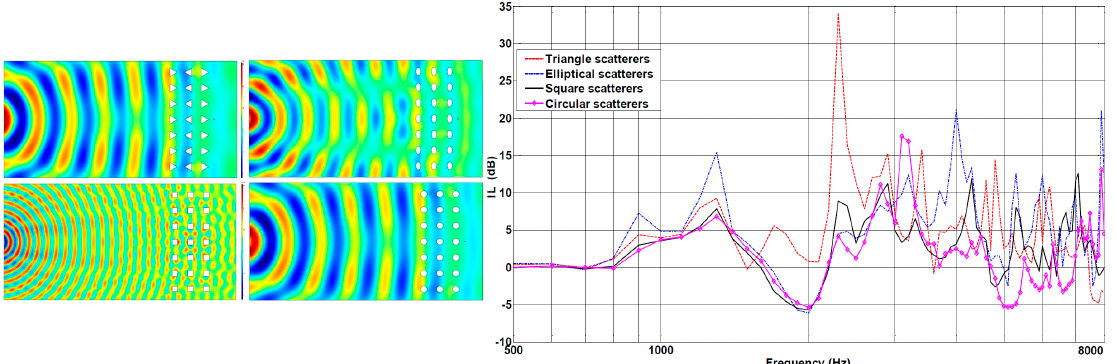
Figure 2. Sound pressure levels (SPL) and insertion loss (IL) for different scatterer shapes, modified from [39].